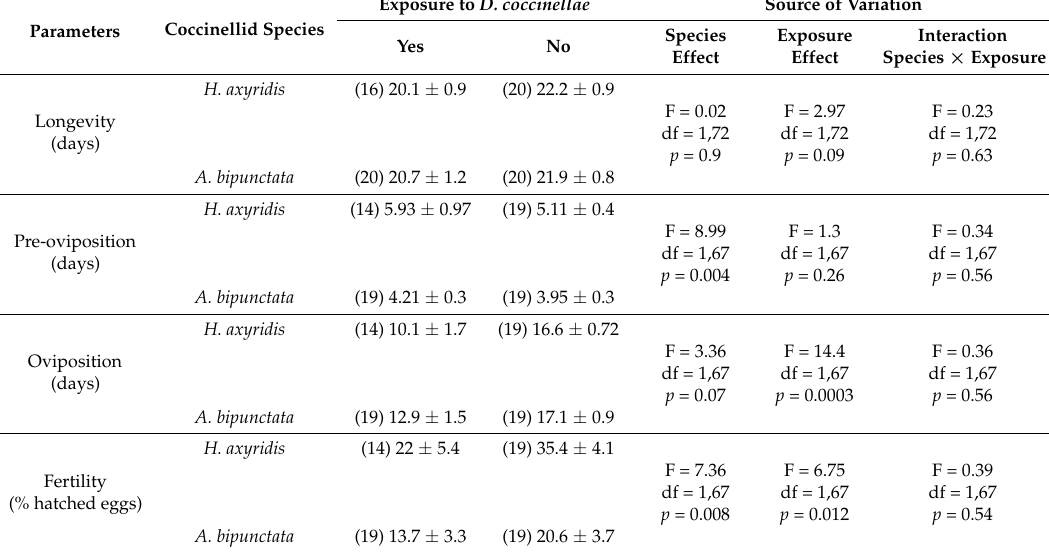
Table 5. Longevity, pre-oviposition and oviposition duration in days, egg fertility (% hatched eggs) of H. axyridis and A. bipunctata females not exposed (controls) or unsuccessfully exposed to D. coccinellae as related to the combination of the factors “coccinellid species” and “exposure to D. coccinellae ” (means ± SE). All females were paired with non- exposed